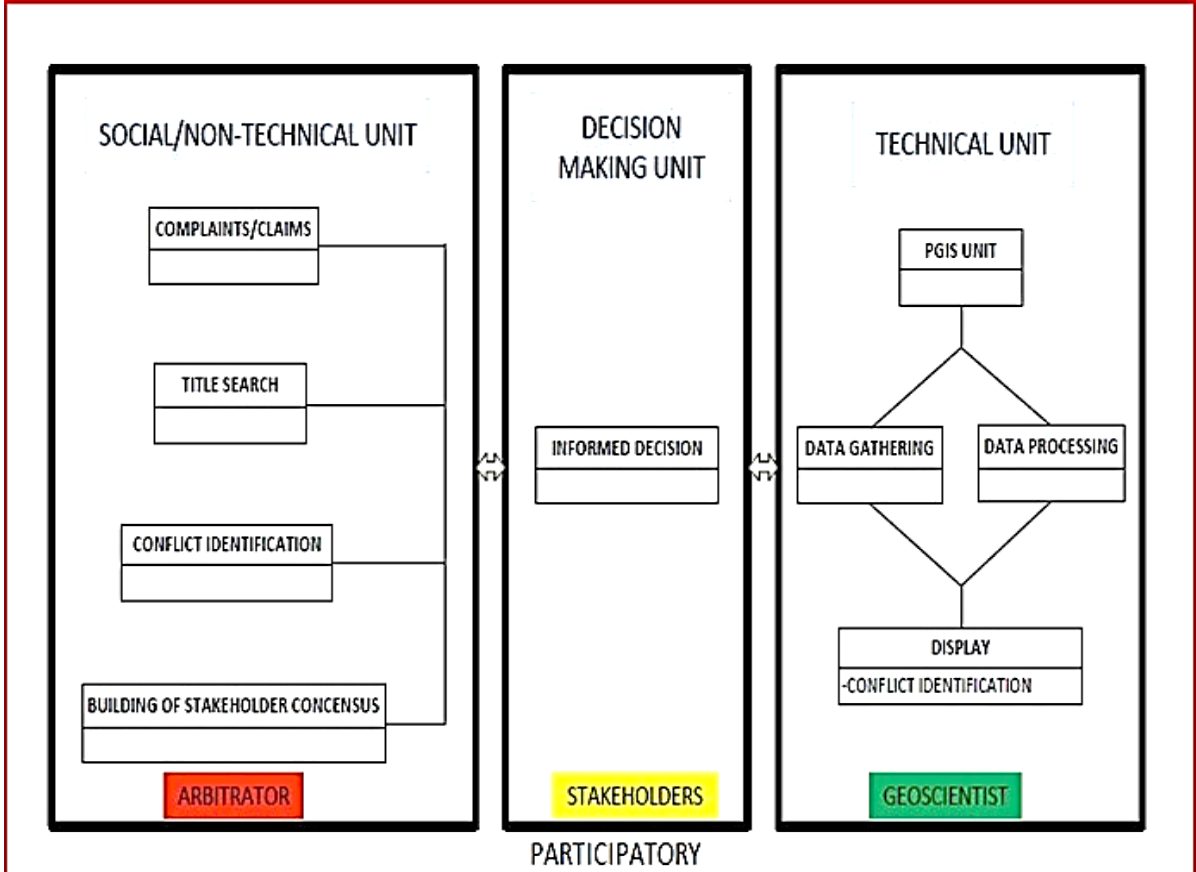
Figure 2. PGIS framework for Land Conflict